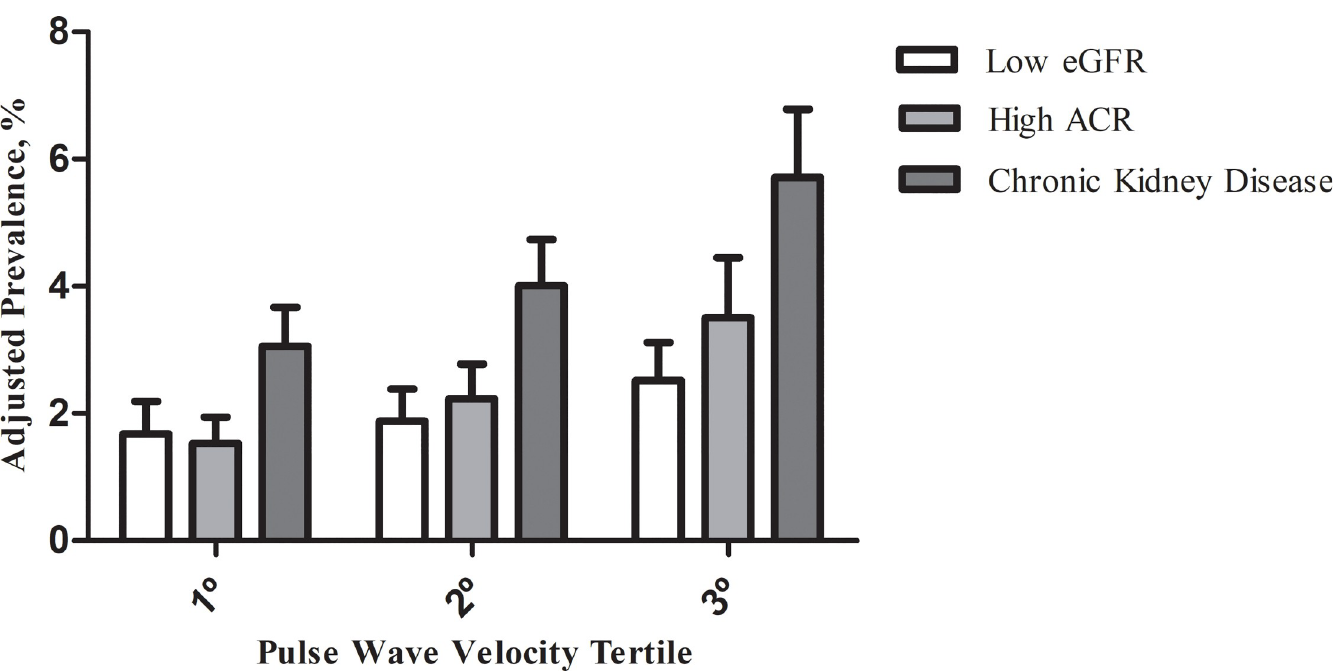
Fig 2. Prevalence of low estimated glomerular filtration rate (eGFR), elevated serum albumin/creatinine ratio (ACR), and chronic kidney disease according to tertile of pulse wave velocity adjusted by age, sex and race/color, and 95% confidence interval in adults free of hypertension and diabetes (ELSA-Brasil, 2008–